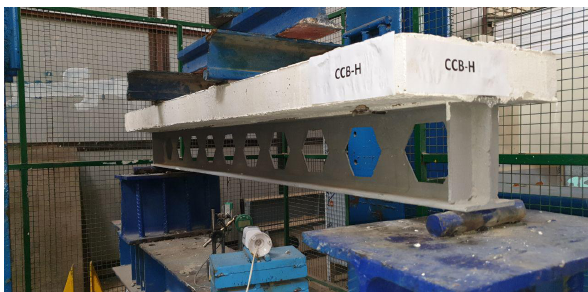
Figure 8: Test setup of Specimen